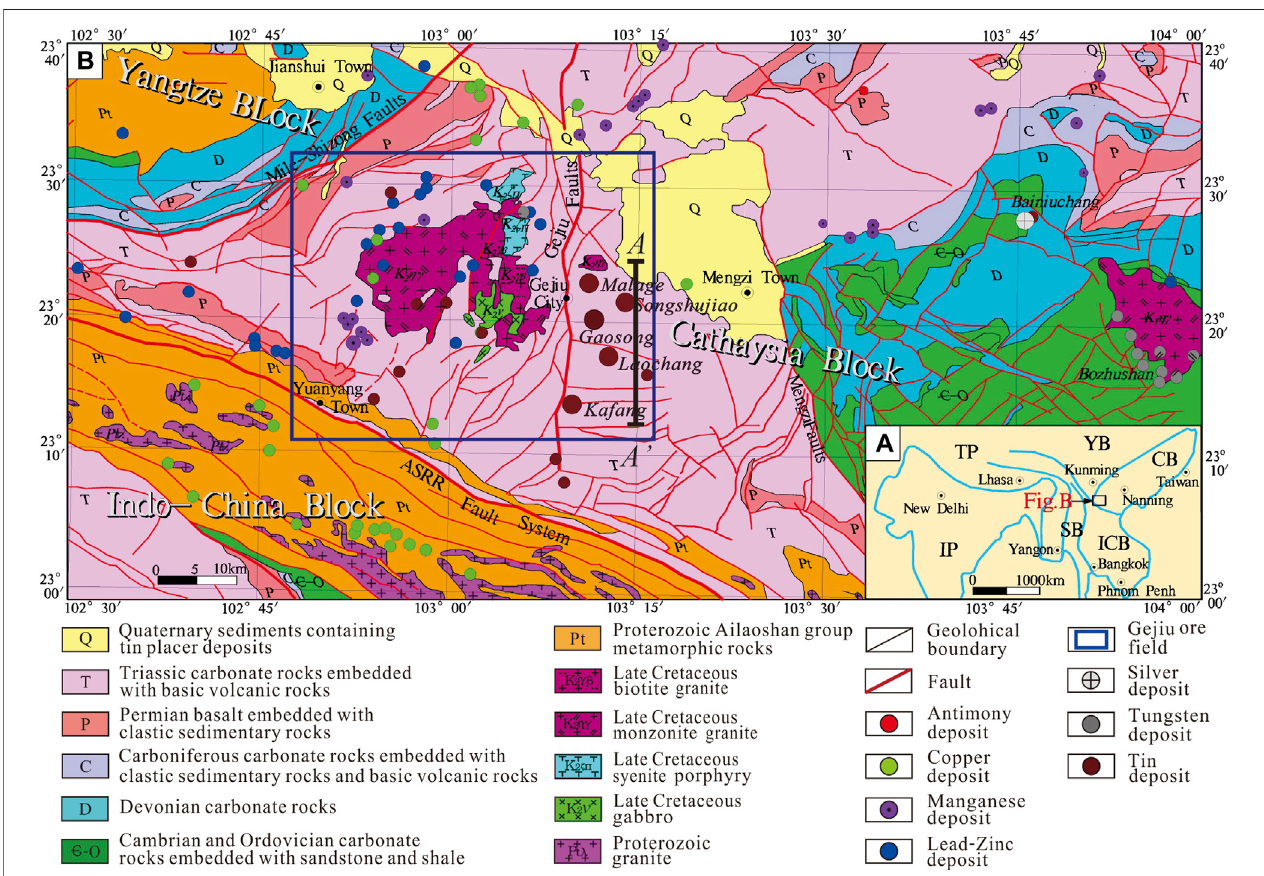
FIGURE 1 | (A) Map of the geological outline of Southeast Asia showing major tectonic units and the location of the Gejiu tin – copper polymetallic ore fi eld [From Cheng et al. (2013)]. (B) Simpli fi ed geological map showing the spatial distribution of intrusive rocks and various types of mineral deposits in the Gejiu tin – copper